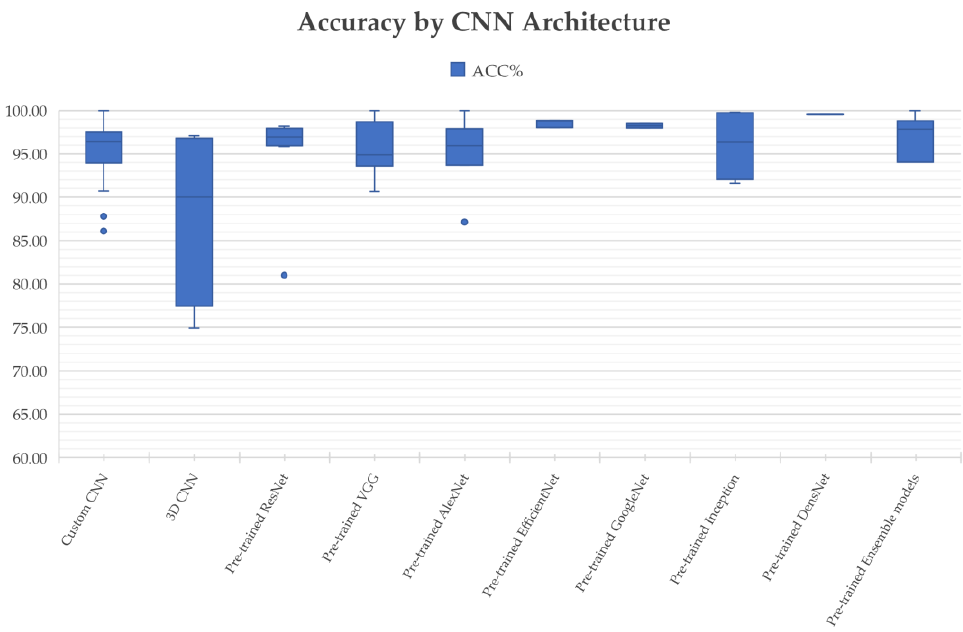
Figure 11. Classification accuracy by CNN architecture.